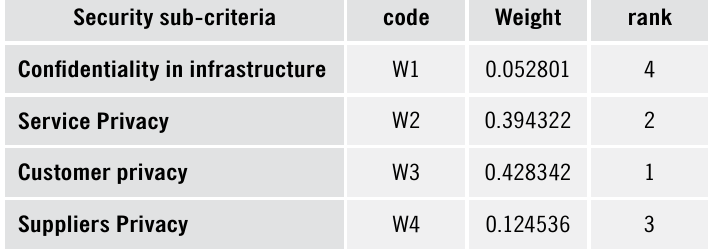
Table 11. Weight of security sub-criteria in privacy (taken from the fuzzy nonlinear model) Security sub-criteria